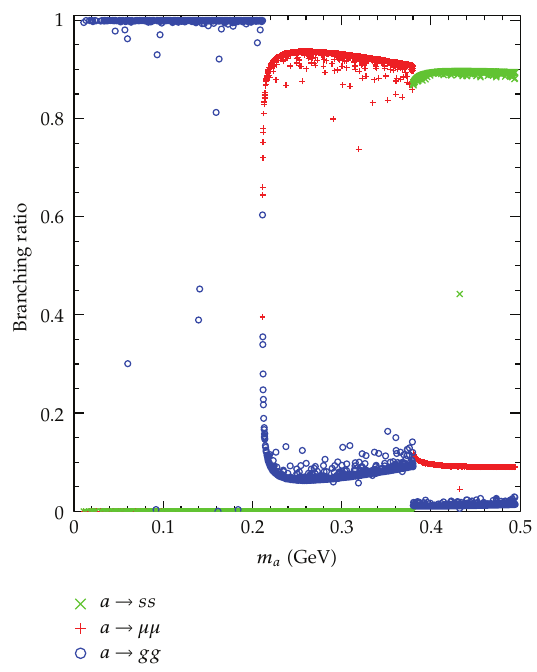
Figure 10: The scatter plots showing the decay branching ratios a → μ (cid:8) μ − (cid:2) muon (cid:3) , a → gg (cid:2) gluon (cid:3) , and a → ss (cid:2) s -quark (cid:3) versus m a for λ (cid:7) 10 − 3 (cid:2) taken from (cid:5) 45 (cid:6)(cid:3) .